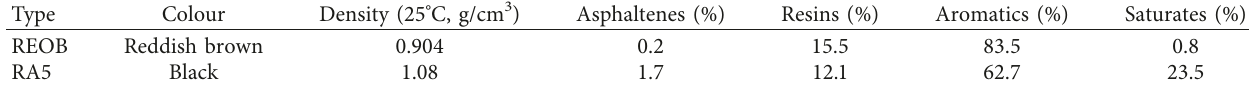
Table 1: Basic properties and chemical components of REOB and RA5.